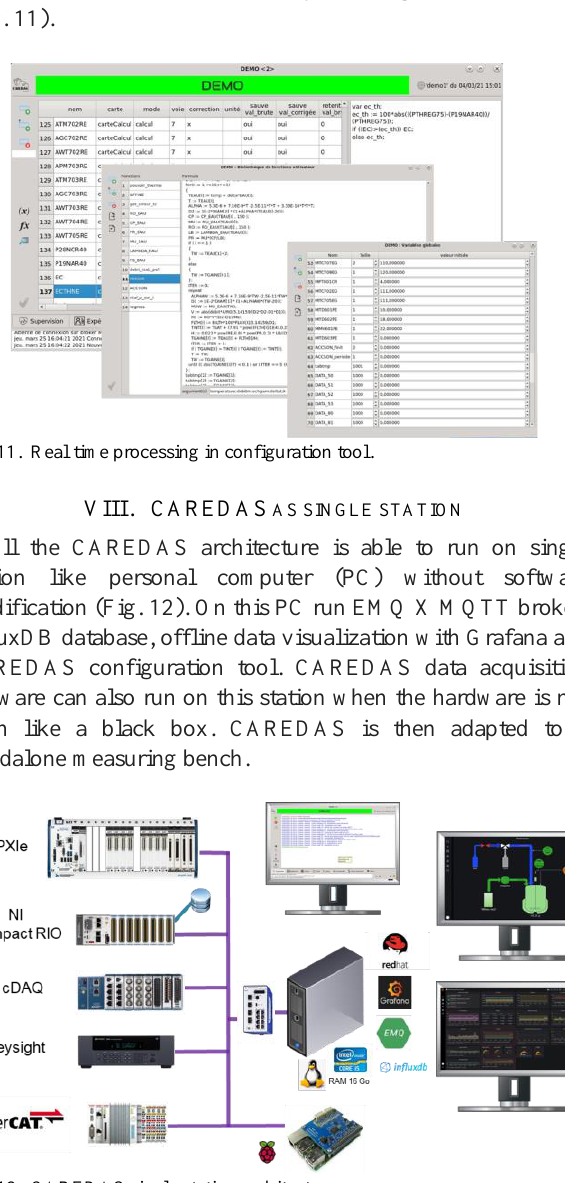
Fig. 12. CAREDAS single station